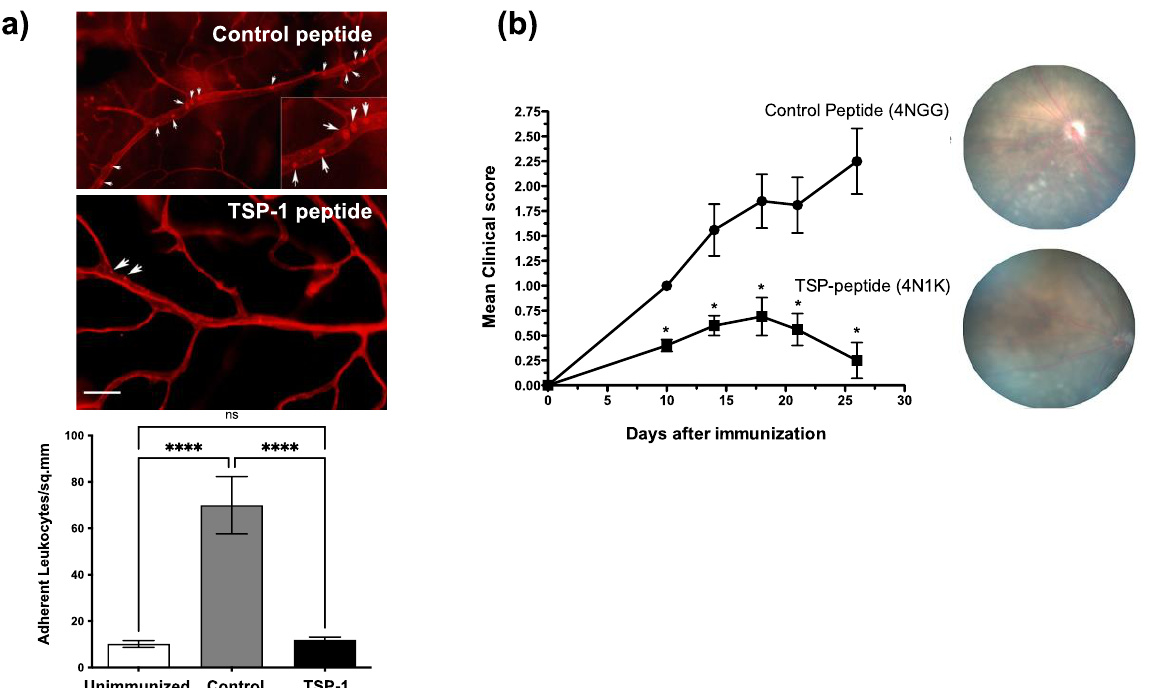
Figure 1. CD47-binding peptide inhibits leukocyte adhesion to retinal vessels in IRBP-induced chronic uveitis in mice. WT mice were immunized s.c. with IRBP (200 µ g) in complete Freund’s Adjuvant and treated once daily with topical application of 4N1K or 4NGG (5 µg per eye). ( a ) Whole mounts of retinas were harvested 7 days post-immunization from rhodamine-ConA perfused mice and imaged to visualize firmly adherent leukocytes (arrows) in retinal vessels. The inset shows a digital magnification of an area. Quantitative analysis of adherent leukocytes is presented in the bar graph. Data are presented as the mean adherent leukocytes per mm 2 ± SEM. ( b ) Clinical course of immunized and treated mice was followed for 30 days post-immunization by weekly fundus exam and scoring, as described in Materials and Methods. Results are expressed as the mean scores ± SEM with representative fundus images. n = 5 per group per experiment. * p < 0.05, **** p < 0.0001. Scale bar = 100 µM.